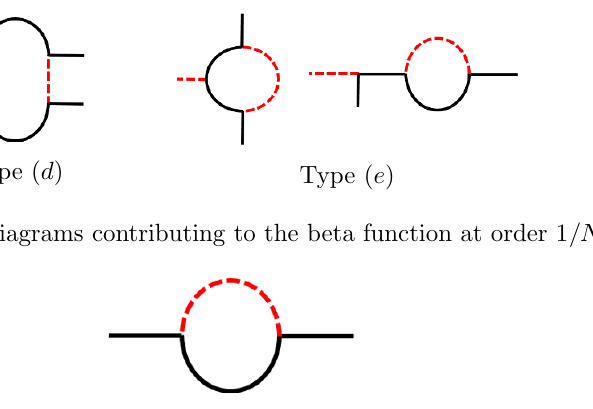
Figure 3. The leading-order contribution to the gamma function of